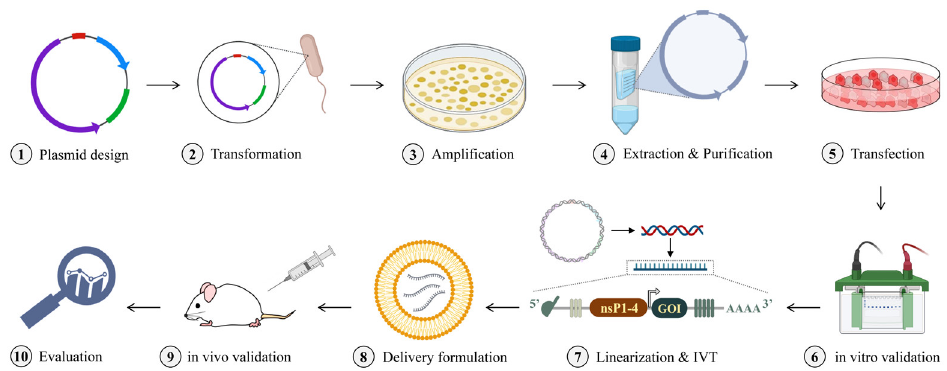
Figure 3. Schematic illustration of experimental design of saRNA treatment for protein deficiency disorders. nsP, non-structural protein; GOI, gene of interest; IVT, in vitro